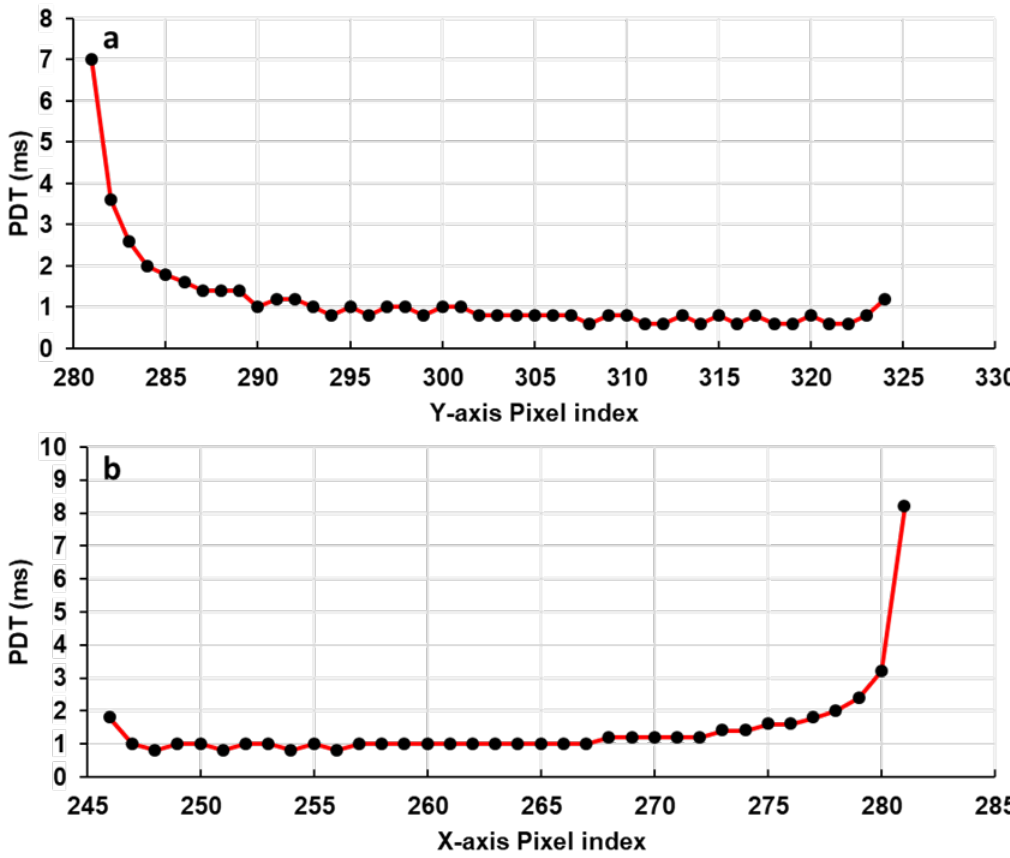
Figure 6. Measured pixel dwell time along a Y -axis scan line ( a ) and along an X -axis scan line ( b ).